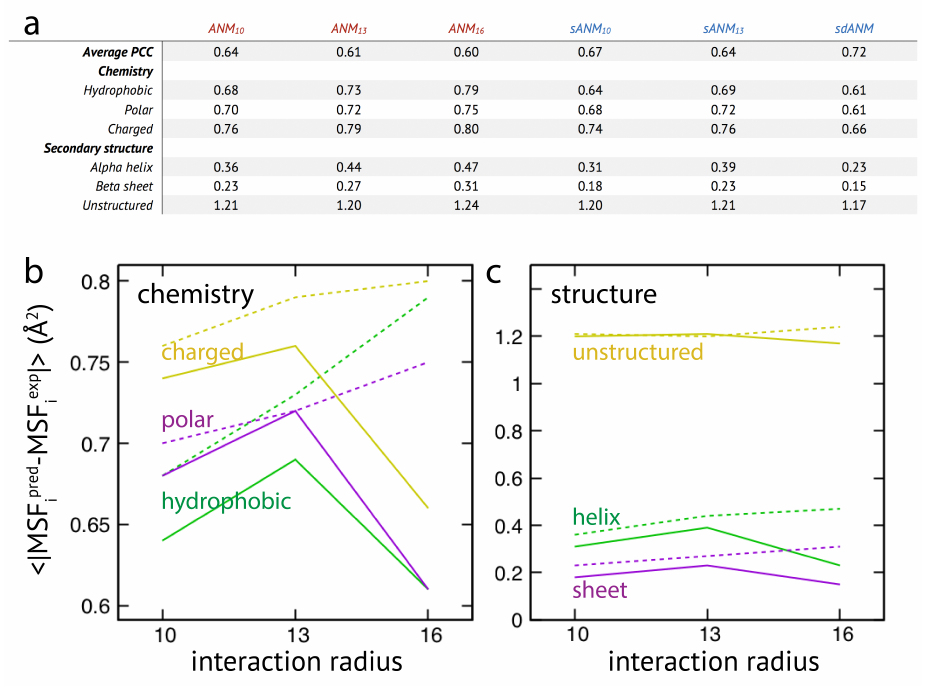
Figure A4. Analysis of predictions by ENM variants for the NMR structural data set. ( a ) The correlation coefficient averaged over all considered proteins is shown for all models (top row). The averaged absolute deviation in MSF predictions for residue beads from groups with different chemical specificity (hydrophobic, polar, and charged) is shown for all models. Also shown is the averaged absolute error for residue beads categorized into different secondary structural elements. In ( b , c ), corresponding graphs are shown. Solid lines correspond to sANM data, where values for sdANM are displayed at interaction radius abscissa position 16 Å. Dashed lines are used for ANM